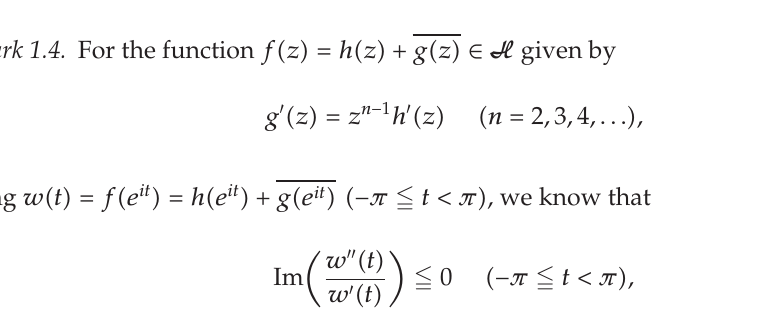
Figure 1: The image of f (cid:3) z (cid:4) (cid:5) (cid:3) 1 − (cid:3) 1 − z (cid:4) 2 (cid:4) / 2 (cid:3) 1 − z (cid:4) 2 (cid:6) z 2 / 2 (cid:3) 1 − z (cid:4) 2